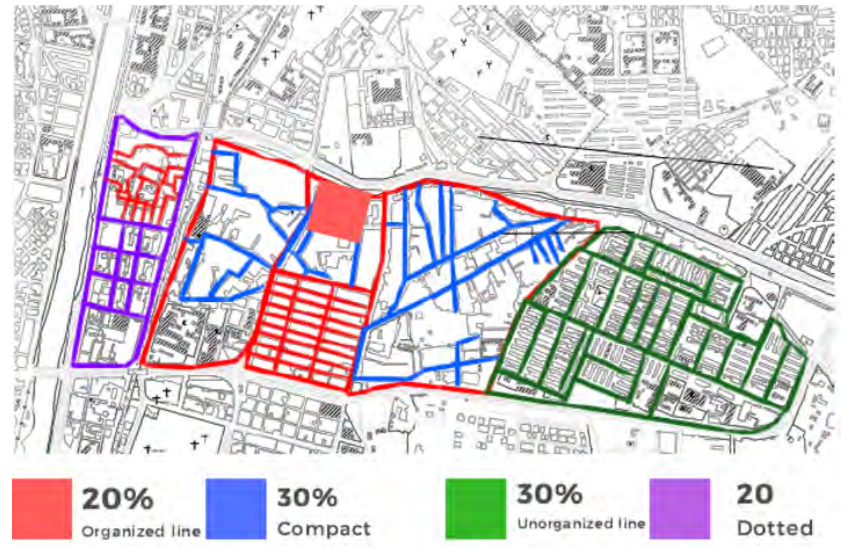
Figure 5. Urban Fabric (Students research)